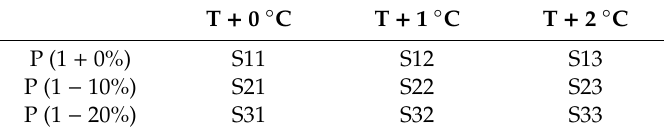
Table 3. Climate scenario setting of Nenjiang River Basin.